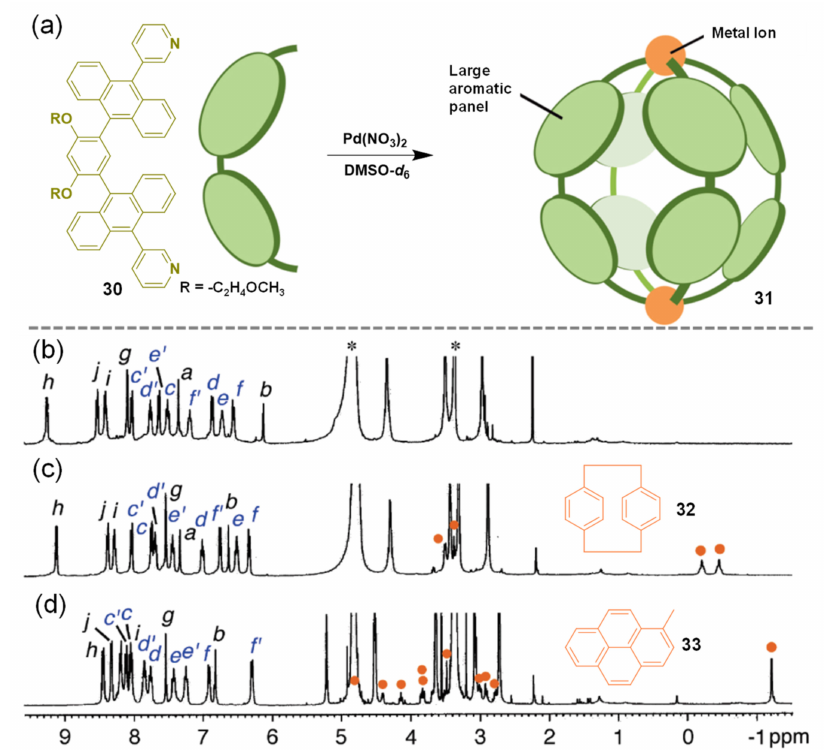
Figure 7. Self-assembly and host-guest chemistry of molecular capsule 31 . ( a ) Schematic representa- tion of the formation of 31 . ( b – d ) 1 H NMR spectra of ( b ) 31 , ( c ) [32 ⊂ 31] , and ( d ) [(33) 2 ⊂ 31] . Orange signals are from the encapsulated guest 32 or 33 . *: solvent signals. Reprinted with permission from Ref. [30]. Copyright 2011 American Chemical